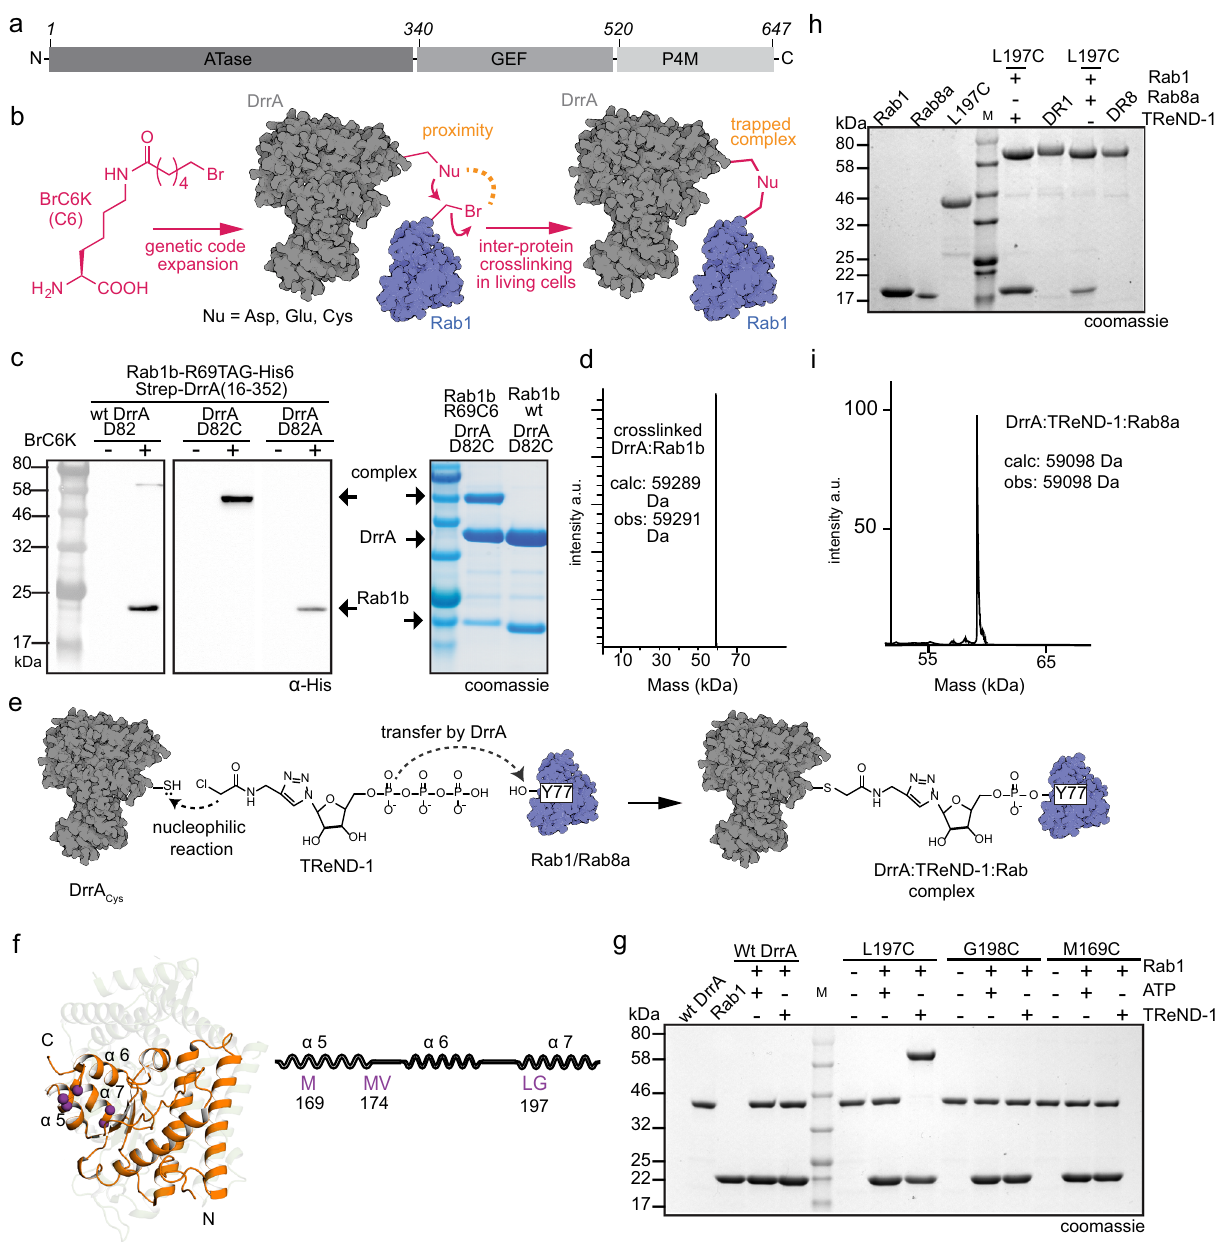
Fig. 1 Conceptual design for stabilising the low-af fi nity DrrAATase:Rab complex. a Schematic representation of domain organisation in full-length DrrA. b Covalent stabilisation of DrrA:Rab using site-speci fi cally incorporated UAAs bearing bromoalkyl moieties (BrC6K). c α -His6 western-blotting analysis of DrrA:Rab1b complex formation in living E. coli cells and SDS-PAGE analysis of in vitro DrrA:Rab1b complex formation. d Intact MS analysis of thioether linked AMPylated Rab1b:DrrA D82C complex (a.u.: arbitrary units). e Trapping the DrrA:Rab complex via thiol-reactive nucleotide analogues. f Selection of Cys substitution sites (M169, M174, V175, L197 and G198, purple) in the model, and superimposition of DrrA 8-218 (PDB: 3NKU, orange) onto GS-ATase (PDB: 3K7D, light green background). g SDS-PAGE shift analysis of DrrA:TReND-1:Rab1b complex formation. h SDS-PAGE shift analysis of preparative DrrA:TReND-1:Rab1b (DR1)/Rab8a (DR8) complex formation. i Intact mass spectrometry analysis of the DrrA:TReND-1:Rab8a complex. Source data are provided as a Source Data fi le.